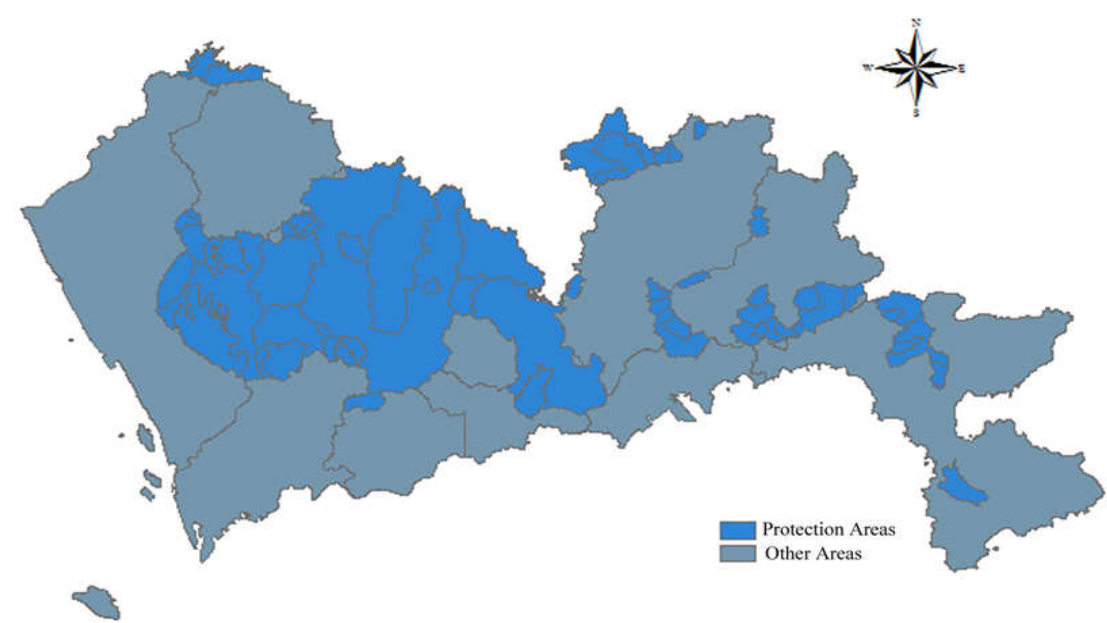
Figure 2. Map of distance to water source protection areas.